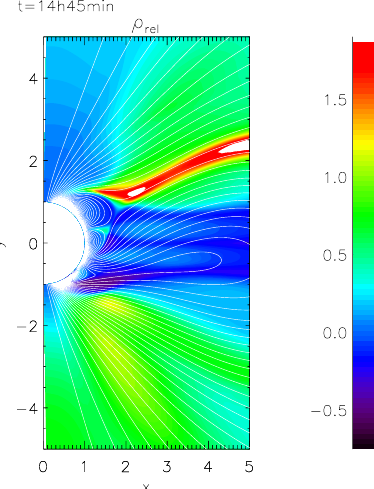
Fig. 6. Snapshot of the relative density and magnetic field lines showing the secondary eruption in the wake of the disconnected streamer top (marked in